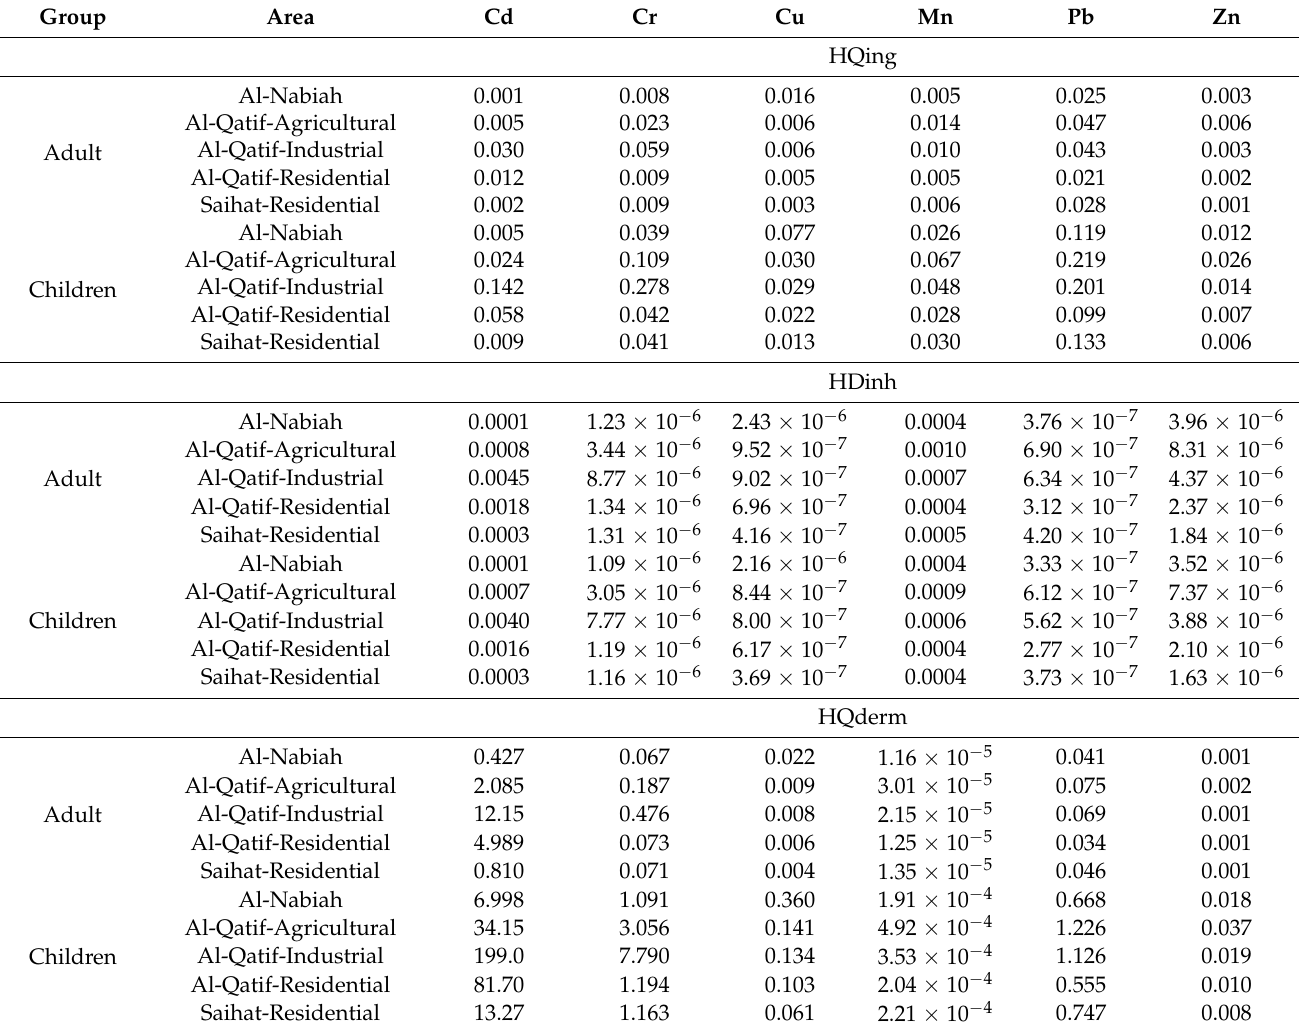
Table 3. Hazard quotient of ingestion (HQing), inhalation (HQinh), and dermal (HQderm) pathways for the potentially toxic heavy metals in the dust of AC filters from different sampling